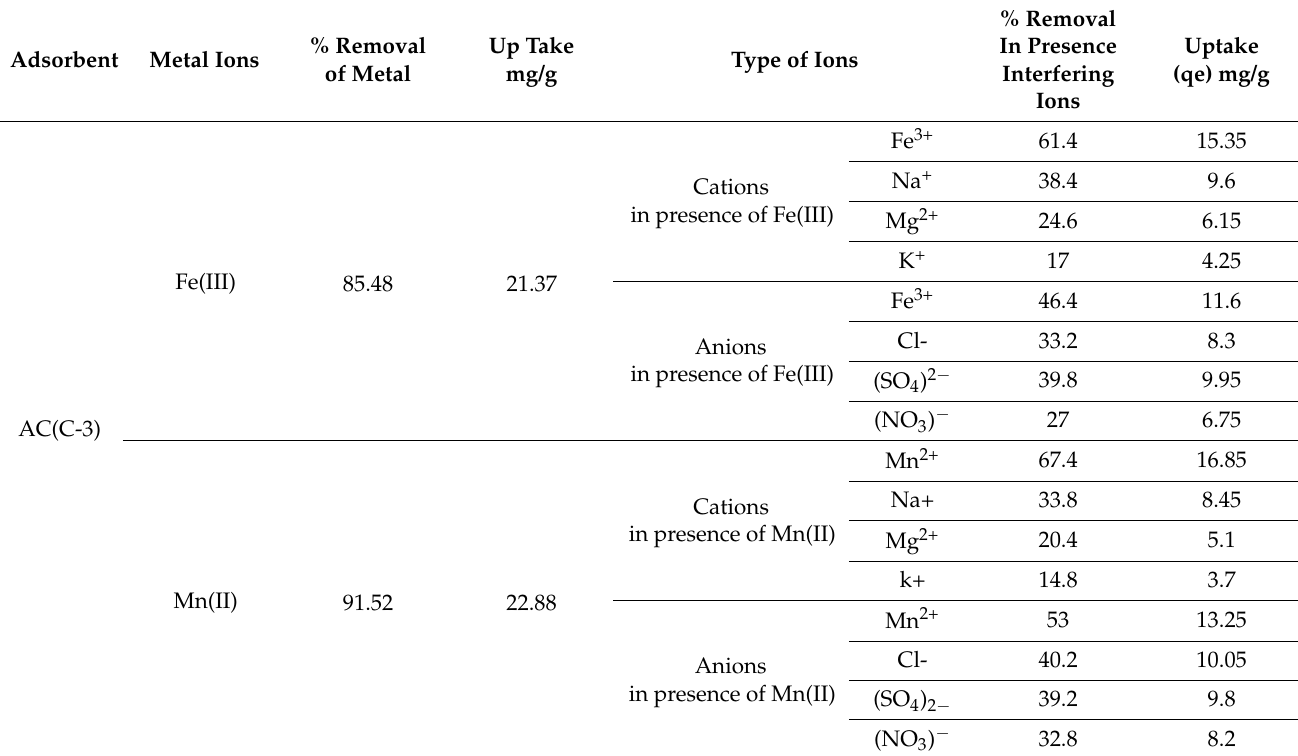
Table 9. Effect of interfering ions on Fe(III) and Mn(II) percent removal as well as uptake on AC(C-3) (from solutions) (contact time 1 h., pH = 3 for Fe(III) and pH = 6 for Mn(II), conc. = 50